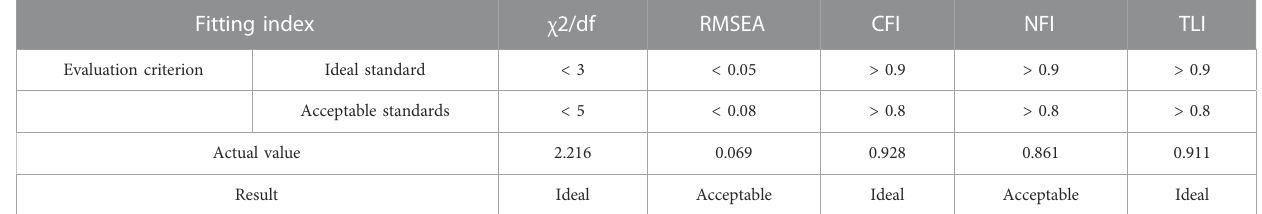
TABLE 9 Model fi t.